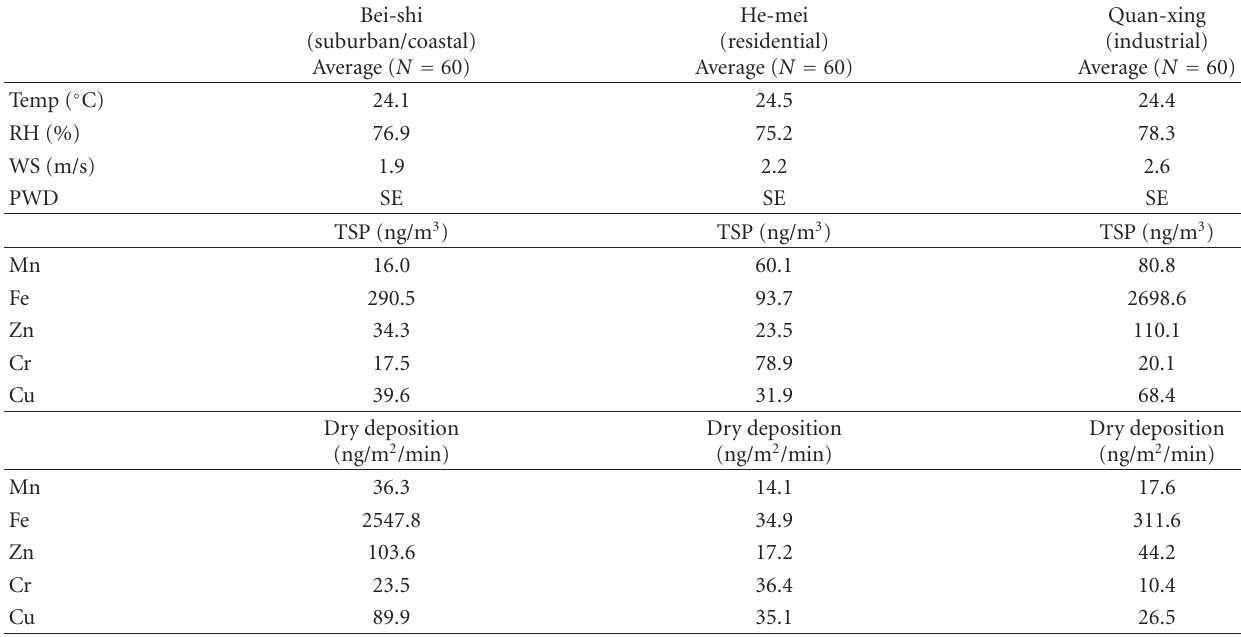
Table 2: Meteorological conditions and average metallic elements (Mn, Fe, Zn, Cr, and Cu) in total suspended particulates (TSPs) and dry deposition at three characteristic sampling sites during year 2009-2010.